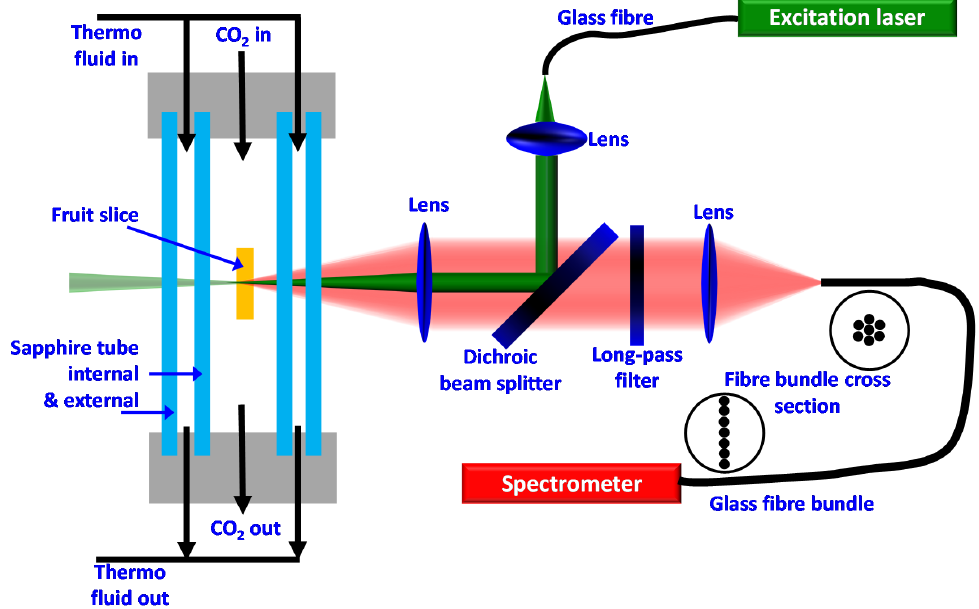
Figure 1. Schematic representation of the experimental setup comprising the double-tubed, optically accessible, high pressure sapphire CO 2 -drying vessel and the design of the Raman sensors.